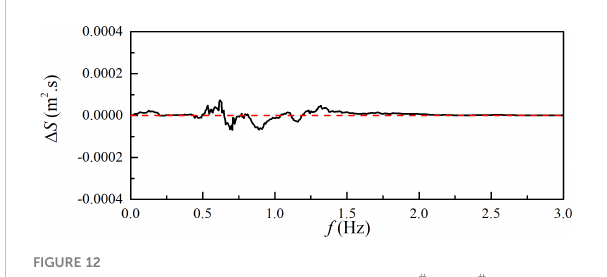
FIGURE 12 The difference of spectra between the stations 7 # and 2 # for case RJ 7 .